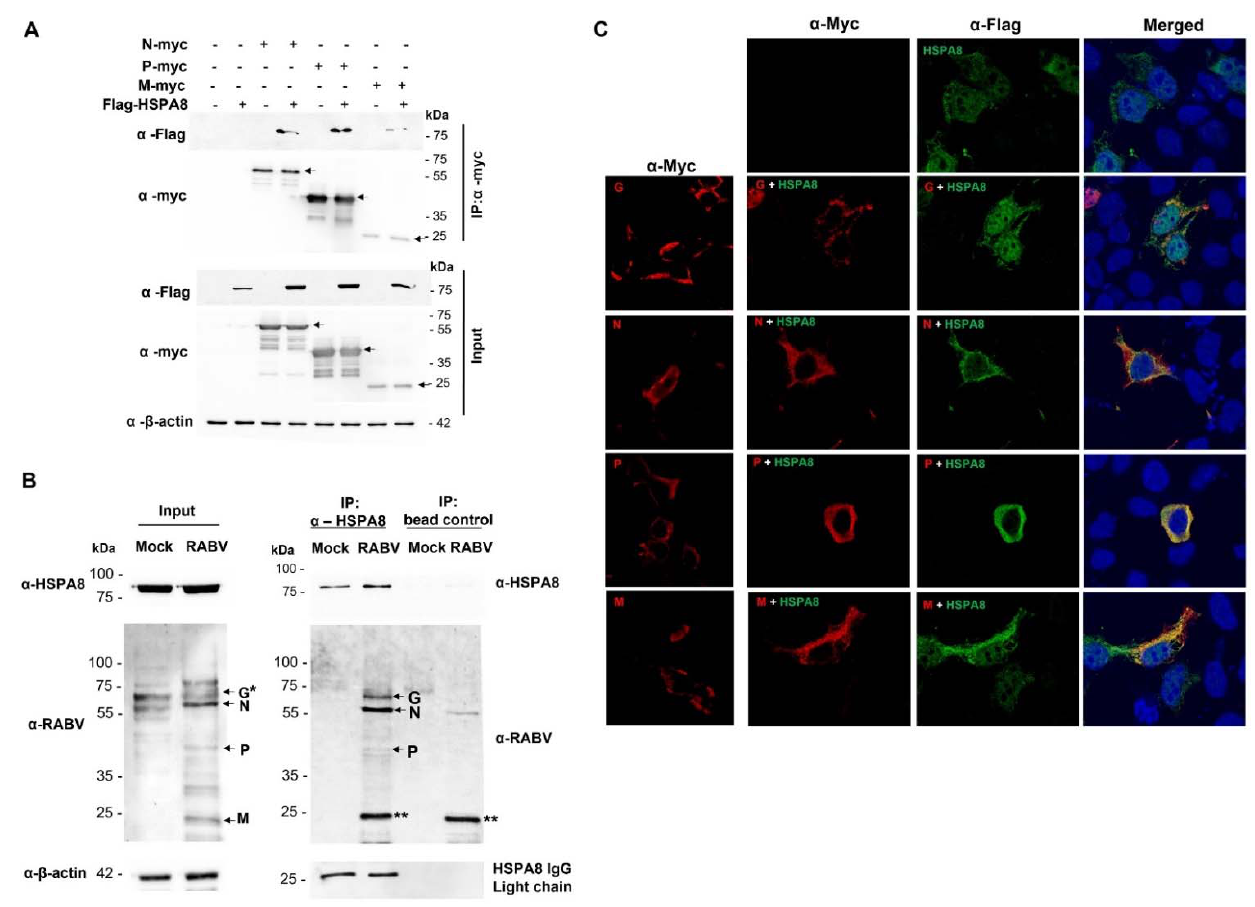
Figure 9. HSPA8 and RABV protein interactions. HSPA8 and RABV proteins’ physical interaction was determined by co-immunoprecipitations of protein samples harvested from HEK293T cells and hiPSC-derived neurons. ( A ) HEK293T cells were transfected with the plasmids expressing Flag-HSPA8 and RABV Nmyc, Pmyc, and Mmyc. At 48 h post-transfection, cell lysates were collected and prepared for immunoprecipitation using mouse α -myc beads. The eluted proteins were probed with rabbit α -myc and –flag. The arrows specify the presence of each viral protein according to its expected size (N, P, and M proteins at approximately 60, 40, and 25 kDa, respectively). ( B ) The neurons were infected with RABV-TH at MOI of 0.5. At 48 hpi, the cells were collected and subjected to immunoprecipitation using beads conjugated with mouse α -human HSPA8 antibody. The same samples were incubated with the beads without α -human HSPA8 antibody conjugation as the negative control. * RABV G appears at the same size as a nonspecific band found in a mock sample. ** RABV M might be either masked by the nonspecific band or strongly binds to the beads, despite lysate preclearing and several washing steps. ( C ) For the colocalization assay, transfected HEK293T cells were fixed with 4% paraformaldehyde and probed with mouse α -myc and rabbit anti-flag as primary antibodies. Goat α -rabbit Alexa Fluor 488 and goat α -mouse Alexa Fluor 647 were used as secondary antibodies.